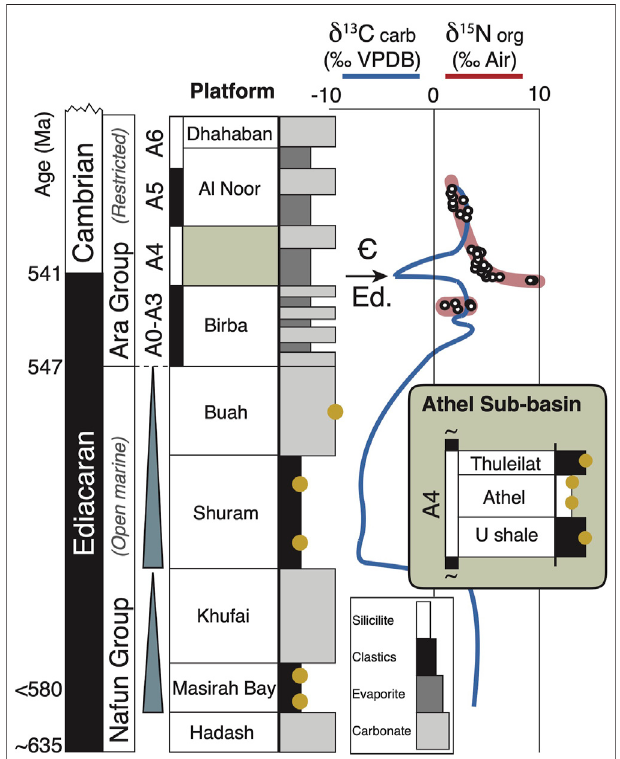
FIGURE 2 | Composite stratigraphy and stable isotope record of the South Oman Salt Basin. Studied samples (yellow circles) represent both open marine and more restricted basinal depositional environments. A composite stable carbon isotope curve (based on platform carbonates [after: Amthor et al., 2003] shows the Shuram anomaly and a characteristic excursion at the Ediacaran – Cambrian boundary. A precisely coincident positive nitrogen isotope anomaly fi rst reported by Fike (2007) suggests a causal connectivity, interpreted as the consequence of sudden overturn and oxidation of a large deep-water pool of ammonium into shallow oxygenated surface waters. Shaded box shows deep-water equivalent strata to the A4 platform